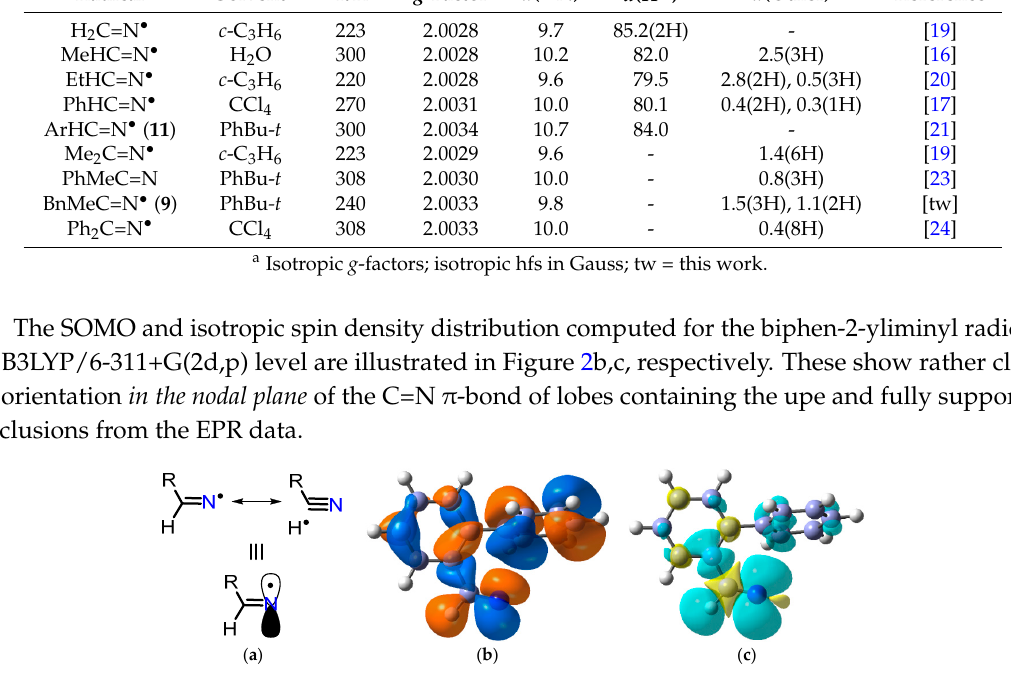
Figure 2. Electronic configuration of alkyl- and aryl-iminyl radicals. ( a ) hyperconjugative interaction; ( b ) DFT computed alpha SOMO; ( c ) DFT computed spin density distribution.